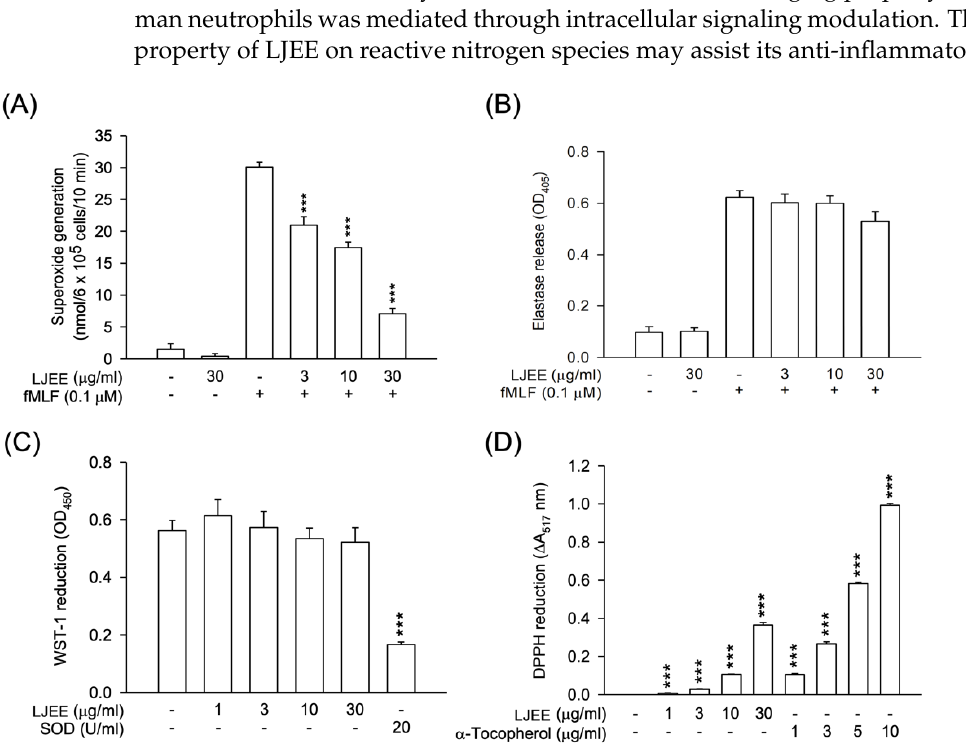
Figure 1. Superoxide anion generation was inhibited by Lonicerae japonicae flos ethanol extract (LJEE), but not elastase release. It exhibited antioxidant activity in N -formyl-methionyl-leucyl-phenylalanine (fMLF)-activated human neutrophils. ( A ) Ferricytochrome c reduction was used to detect the superoxide anion inhibition by LJEE (3–30 µ g/mL). ( B ) The release of elastase was detected spectrophotometrically at 405 nm. A cell-free system was used to assess the antioxidant activity. ( C ) Superoxide-scavenging effect of LJEE (3–30 µ g/mL) was detected by the reduction of 2-(4-Iodophenyl)-3-(4-nitrophenyl)-5-(2,4-disulfophenyl)-2H-ter-trazolium monosodium salt (WST-1). ( D ) ROS-scavenging effect of LJEE (3–30 µ g/mL) was assessed by the reduction of DPPH ( ∆ A 517 nm). All data are presented as the mean ± S.E.M. ( n = 5–7). *** p < 0.001, compared with the DMSO +